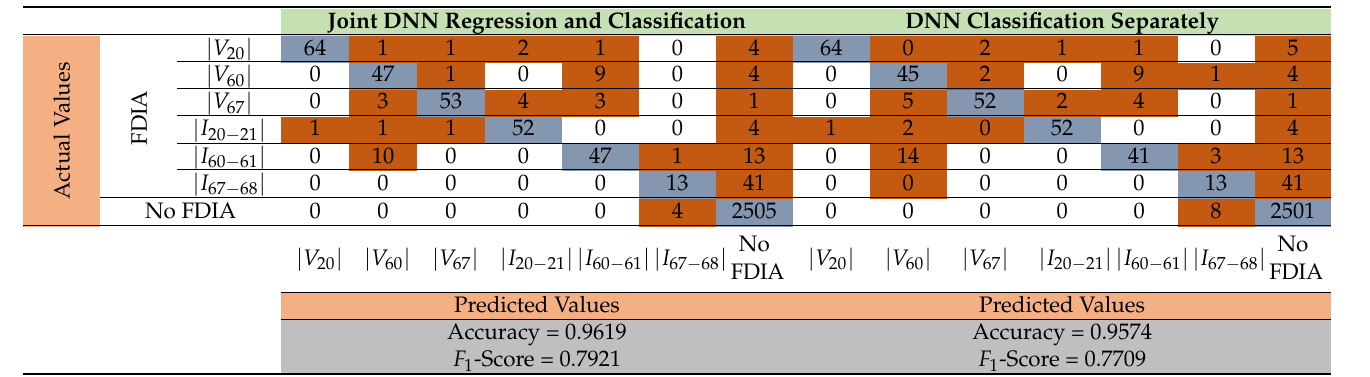
The results of DSSE calculation from the proposed method, the regression-only method, and the WLS method are shown in Figure 13. It is clear from this figure that the proposed method has a better performance in the MPE and MAE criteria compared to the other methods in the presence of bad data. Once again, when no bad data are present, both DNN- based methods (regression-only and combined regression and classification) have similar performance for state estimation. The WLS estimator has the worst performance in both cases, and the performance is significantly worse in the presence of bad data measurements.